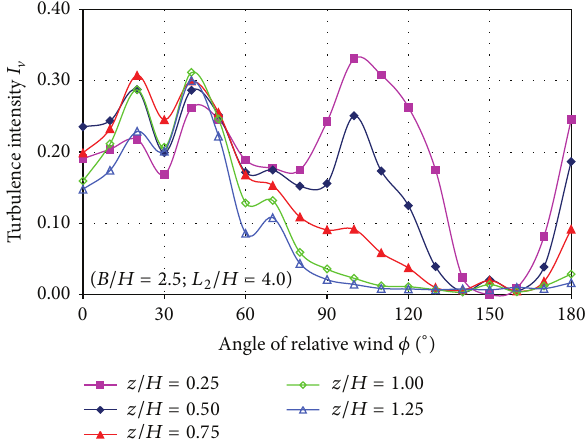
Figure 13: Turbulence intensity of the V velocity component as a function of relative wind